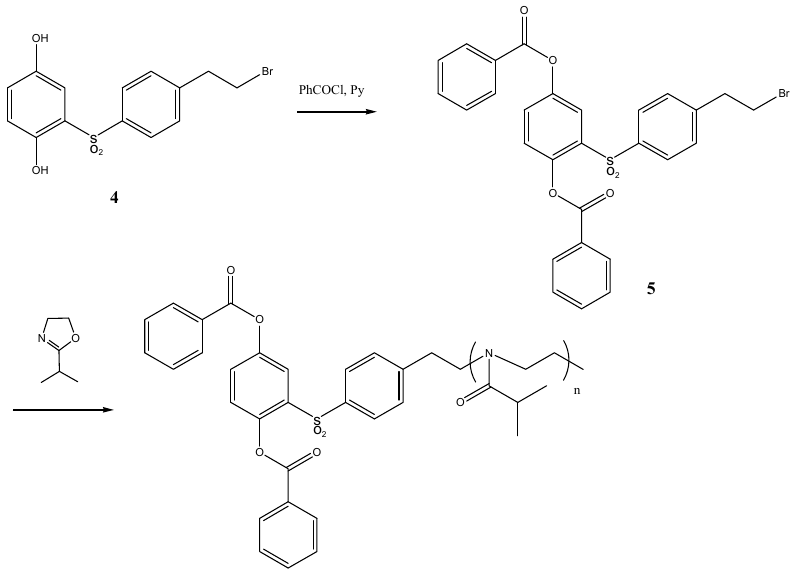
Figure 5. Synthesis of the model poly(2-isopropyl-2-oxazoline).